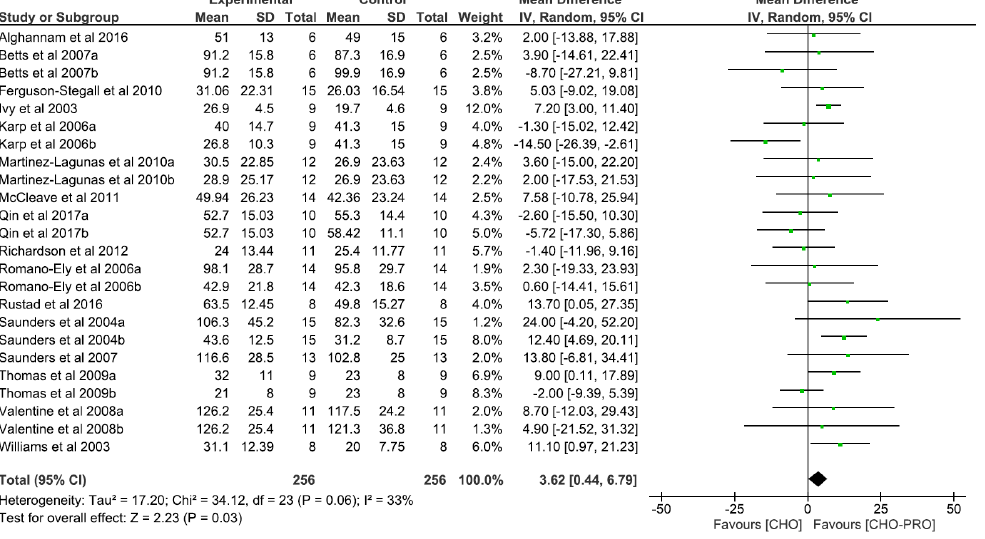
Figure 3. Effect of CHO-PRO on TTE performance compared to carbohydrate (CHO). CI: confidence interval; MD: mean difference.